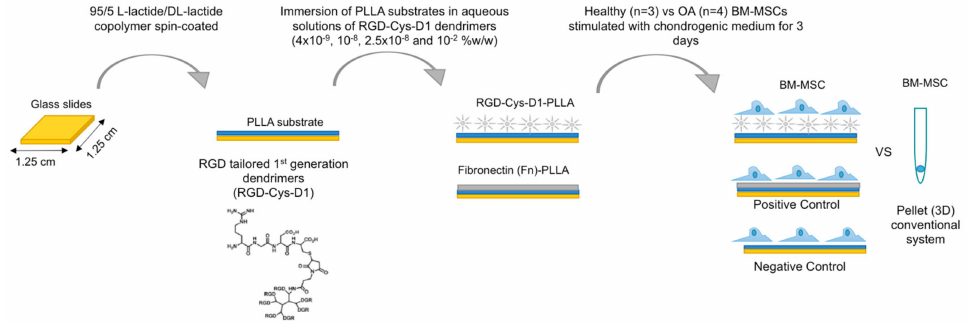
Figure 1. Schematic representation of the RGD-Cys-D1 PLLA nanopatterned substrates preparation process and cell